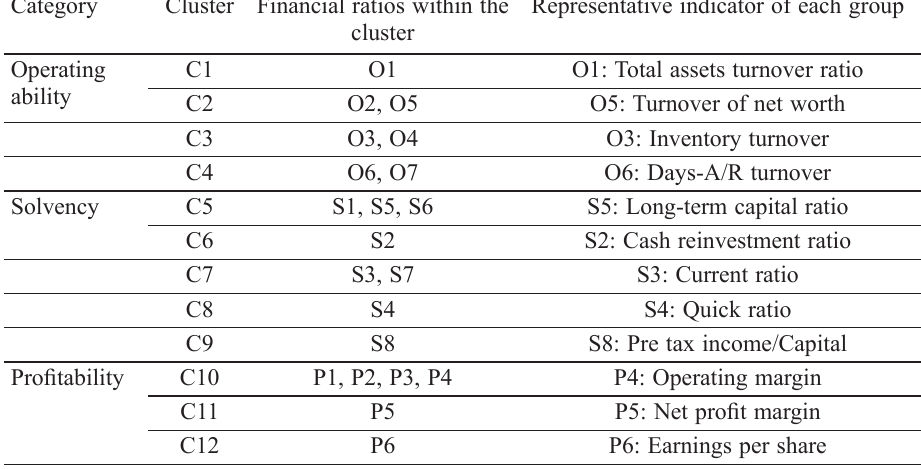
Table 3. The classification of financial ratios and selection of the representative indicators Category Cluster Financial ratios within the